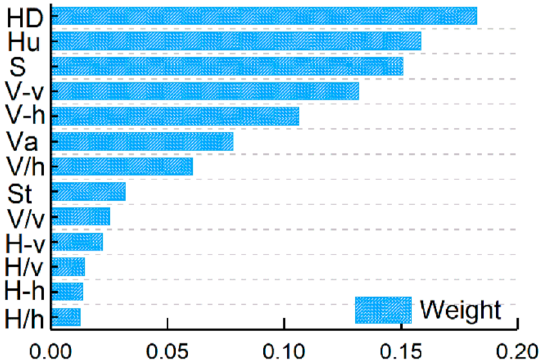
Figure 14. Feature importance ranked by the RF algorithm, HD, S is relative height difference and slope, Hu, St, and Va are hue, saturation, value of the HSV Color space; V,v is VV N + 1 and VV N1 and H, h are VH N + 1 and VH N1